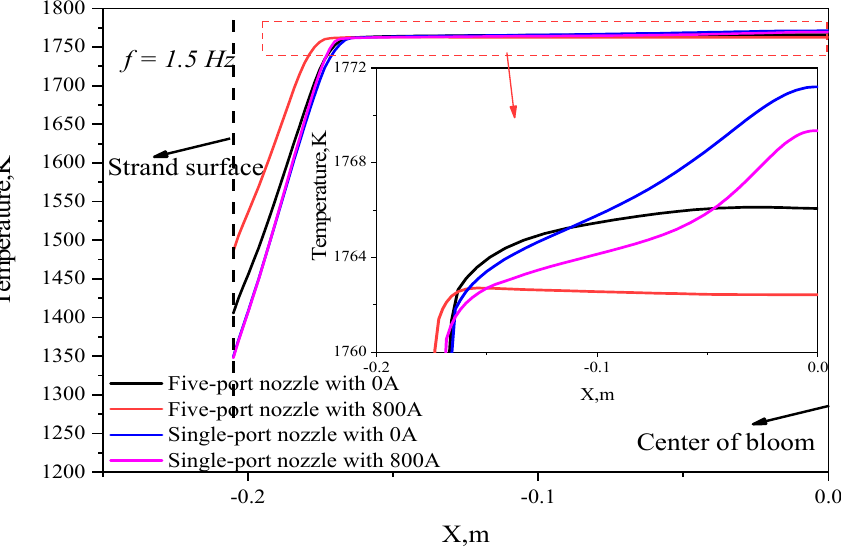
Figure 9. Temperature distribution along the X direction of the mold exit (Z = 635 mm).